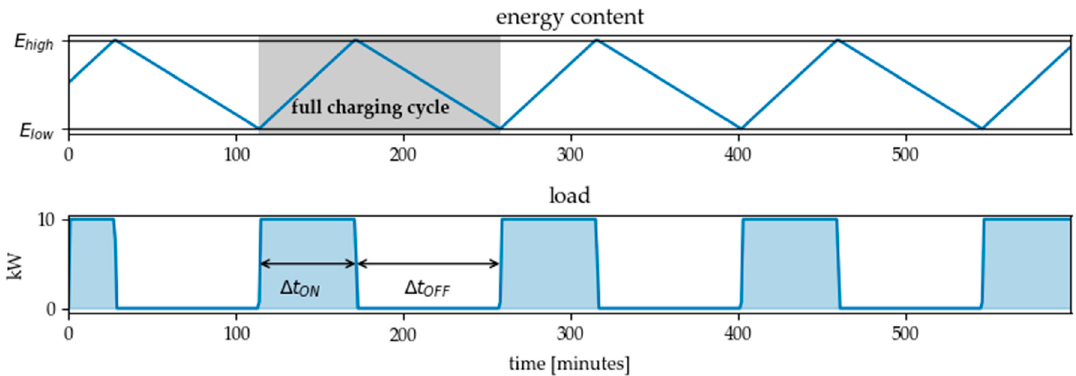
Figure 3. Resulting reference load profile for a heated water tank (volume = 1 m 3 , temperature hysteresis = 5 K, nominal electrical power of heating element = 10 kW, discharging power = 40% of nominal electrical power constantly).